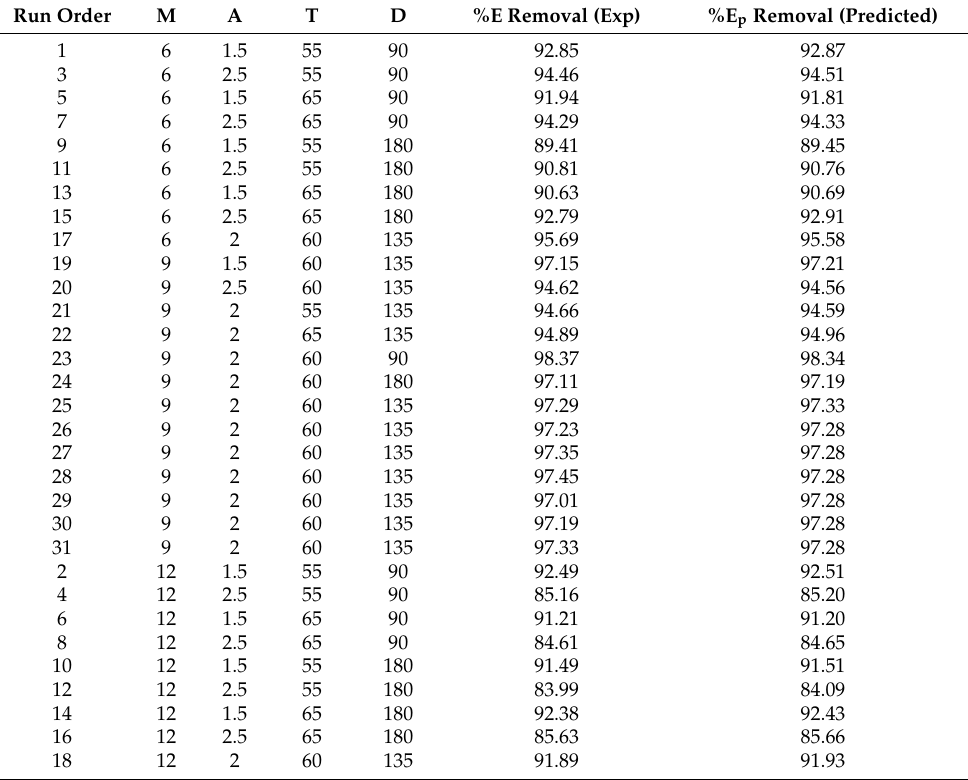
Table 8. RSM analysis of the esterification process with percentile quantity of the experimental and predicted acidity